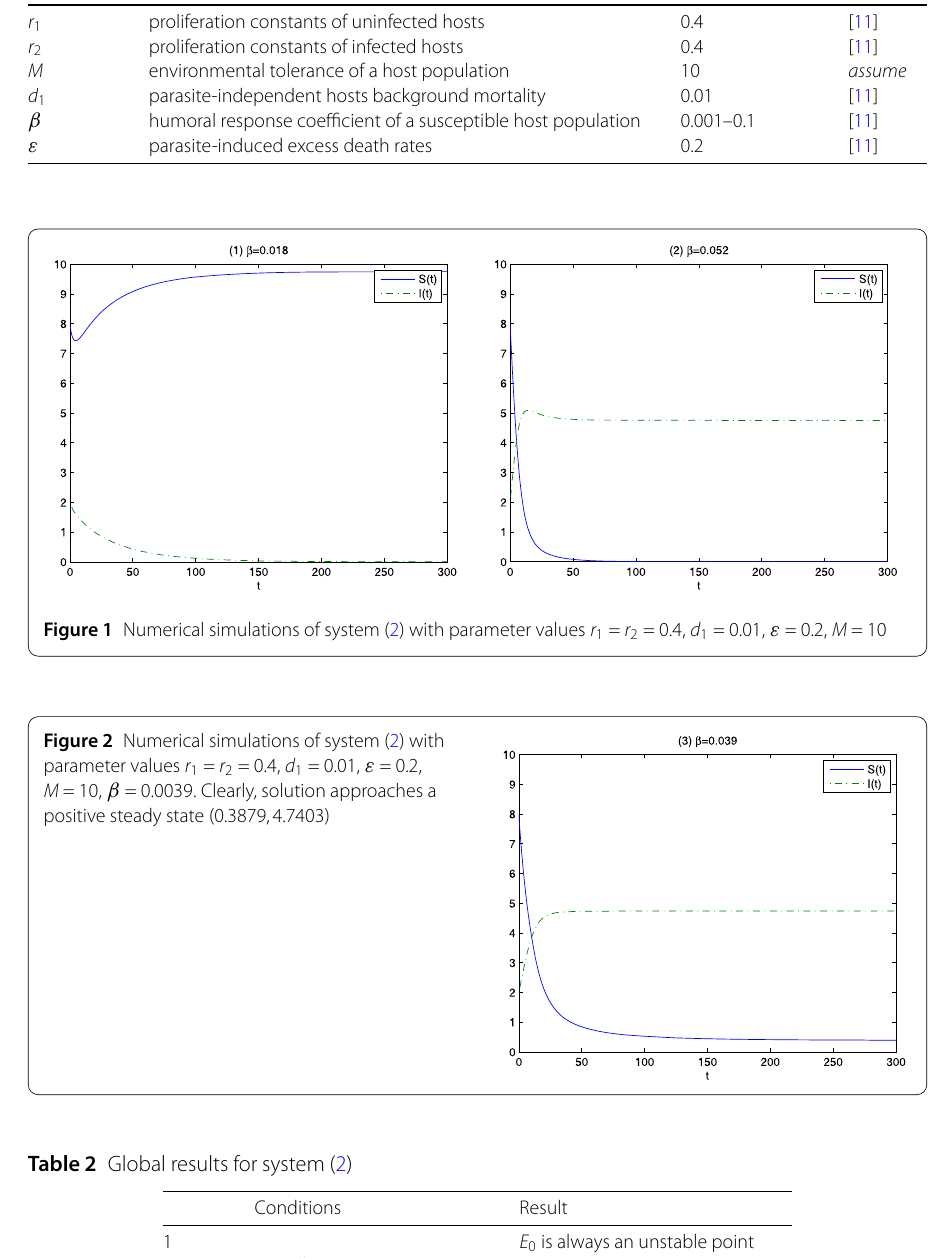
Table 1 Parameters involved in the model Parameter